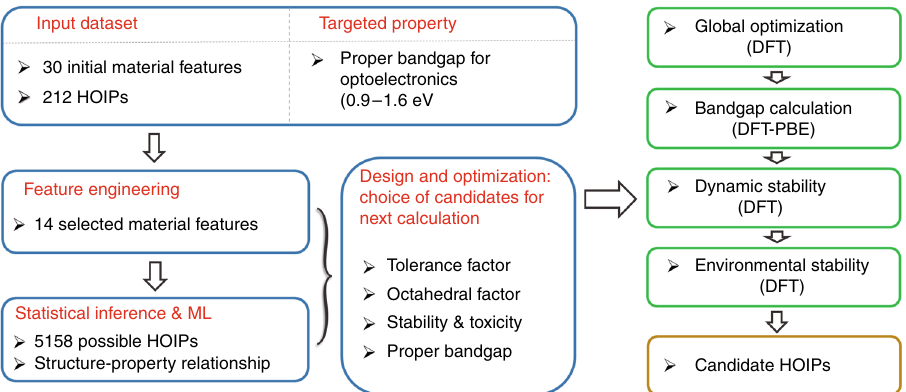
Fig. 1 Lead-free HOIPs design framework. The material design framework combined with ML and DFT to ef fi ciently search for stable Pb-free HOIPs with proper bandgap. The blue boxes represent the material screening process based on the ML algorithm generated from historical HOIP data. Then electronic properties and stability evaluation of these selected candidates are further calculated using DFT, which are shown in the green boxes